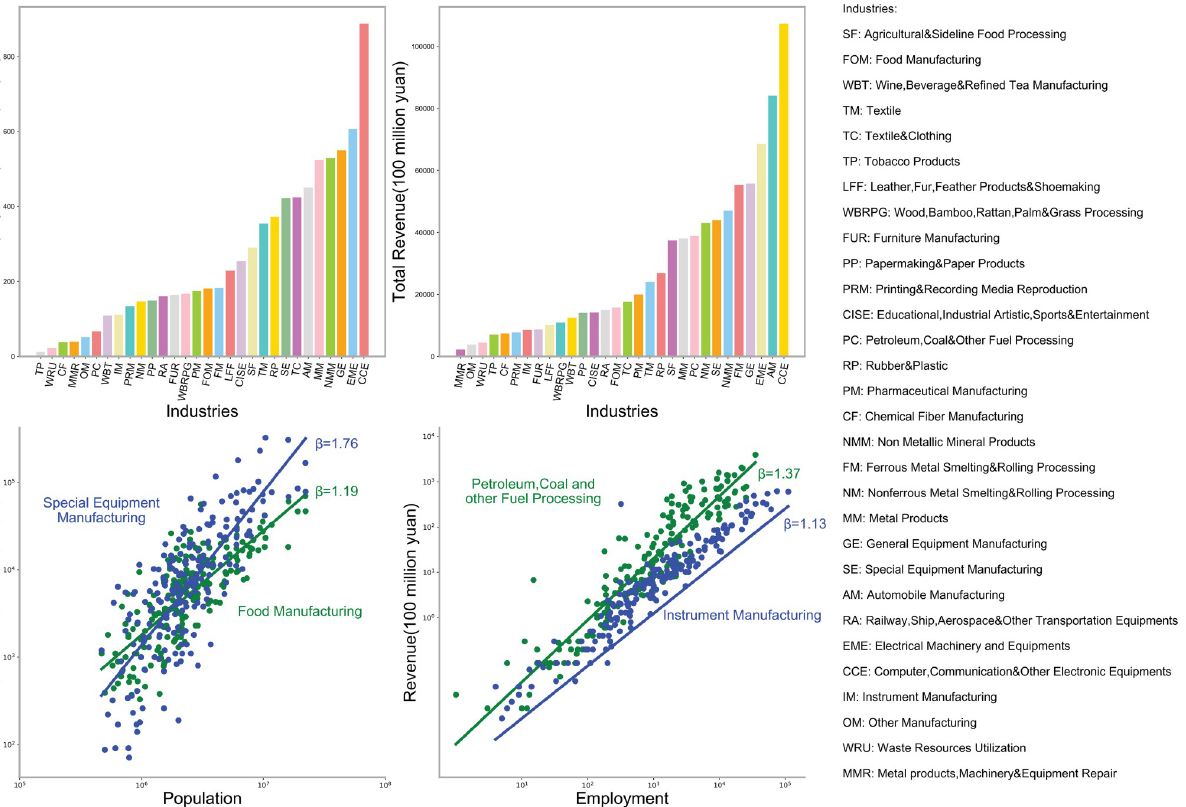
Fig 2. Urban scaling of manufacturing activities. (A) Total employment by industries and (B) Total Revenue by industries. Scaling relations between (C) urban population and industrial employment for “food manufacturing” and “special equipment manufacturing”. (D) industrial employment and annual revenue for “petroleum, coal, fuel processing” and “instrument